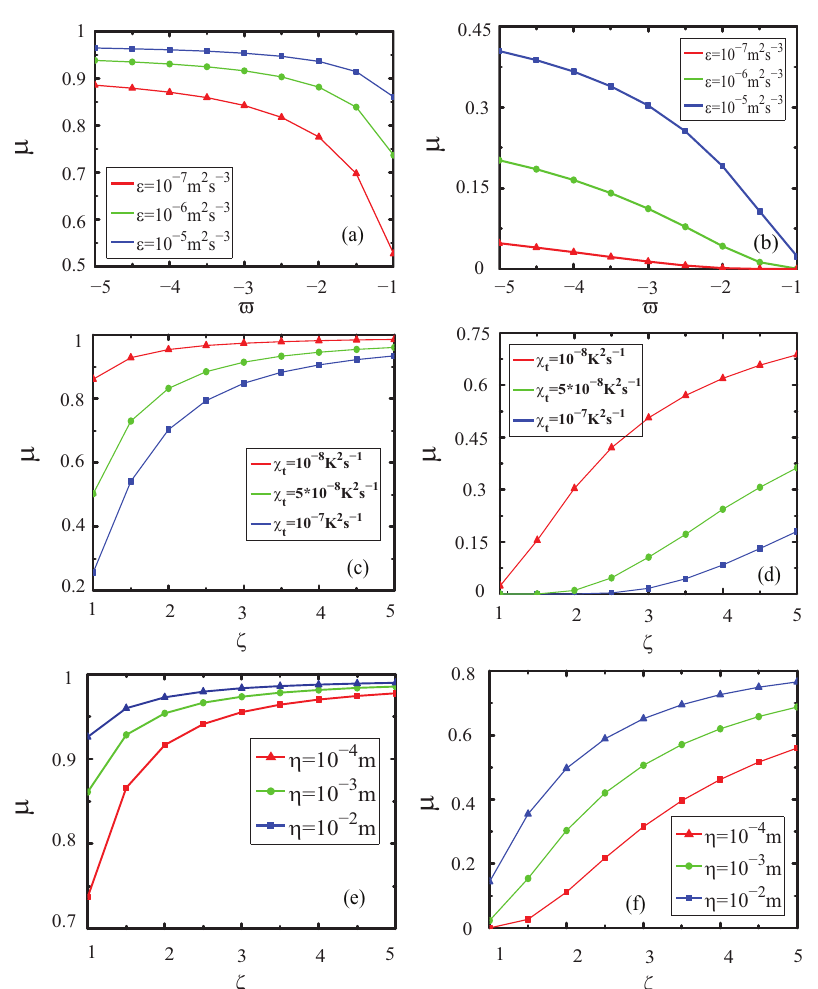
Figure 9. Spectral degree of coherence of the OAHGSM vortex beam passing through anisotropic oceanic turbulence with different ε , (cid:118) , χ t , ζ , and η at z = 1200 m. Two points are fixed at ρ 1 = ( 0.1 cm, 0), ρ 2 = ( 0,0 ) for ( a , c , e ) and ρ 1 = ( 0.5 cm, 0), ρ 2 = ( 0,0 ) for ( b , d , f